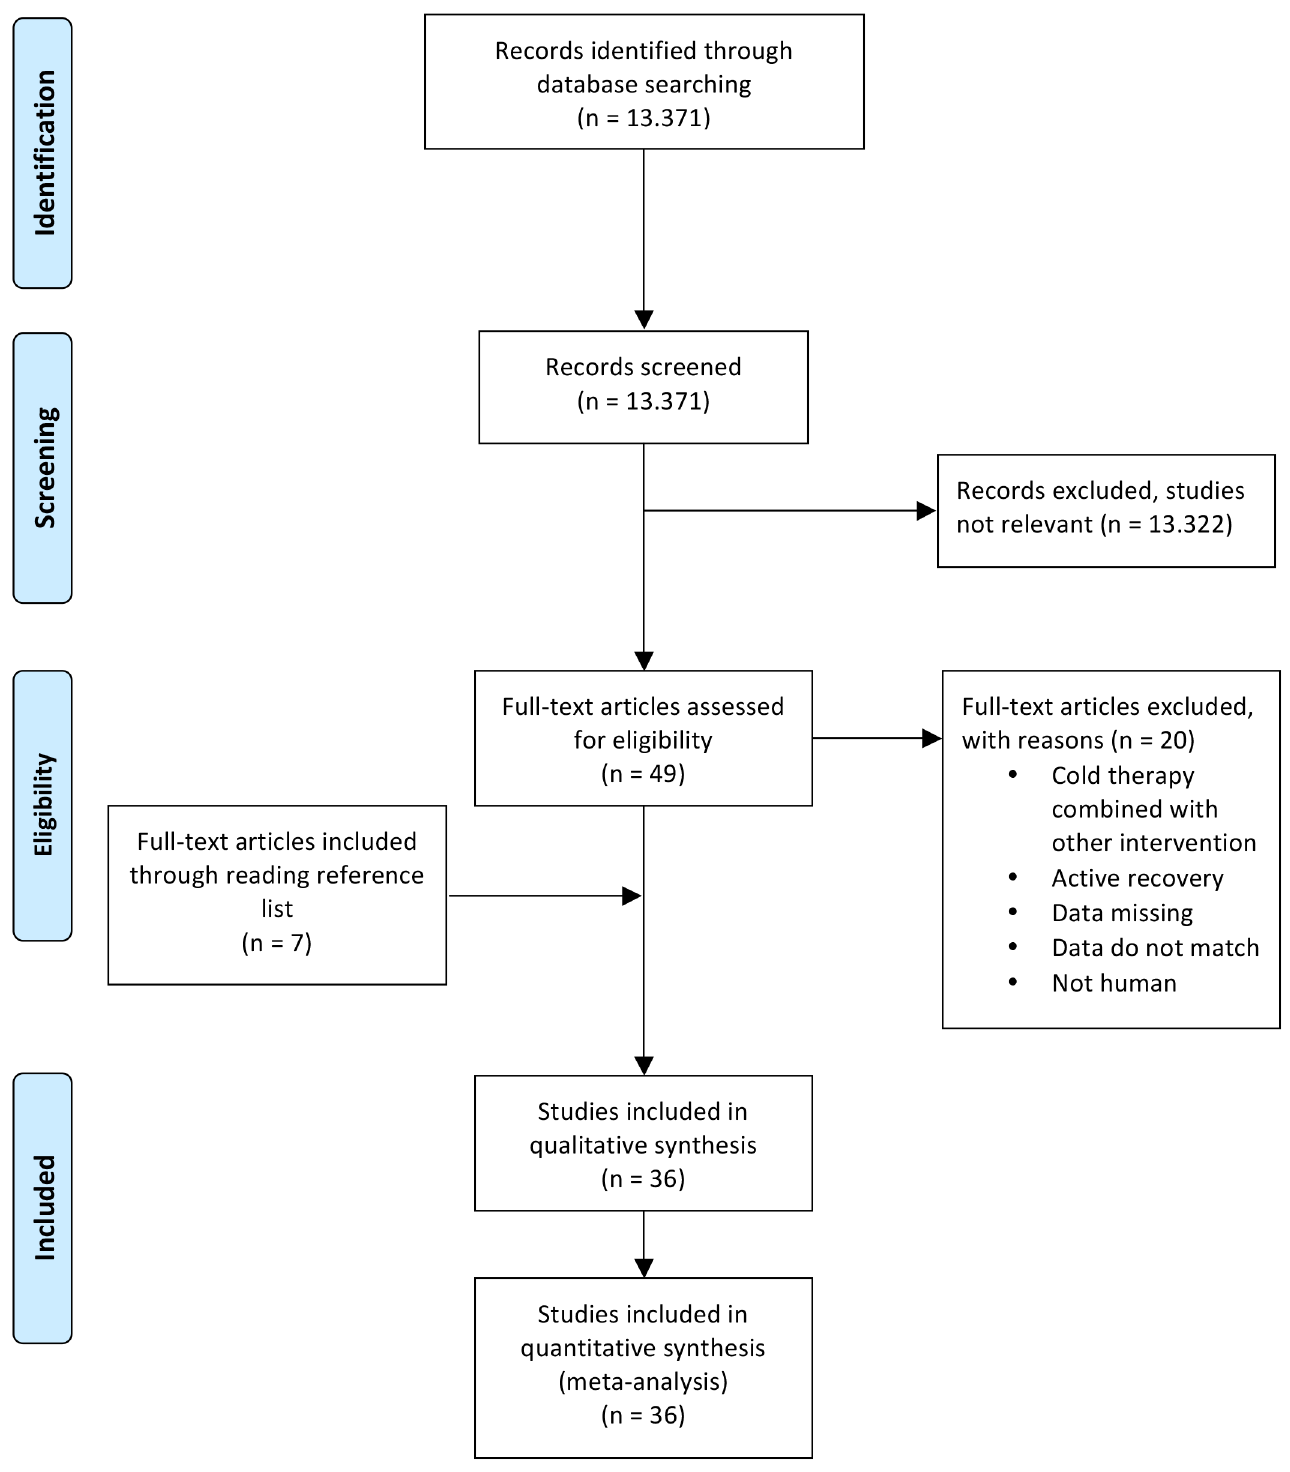
Fig 1. Flow-chart describing the systematic review procedure.